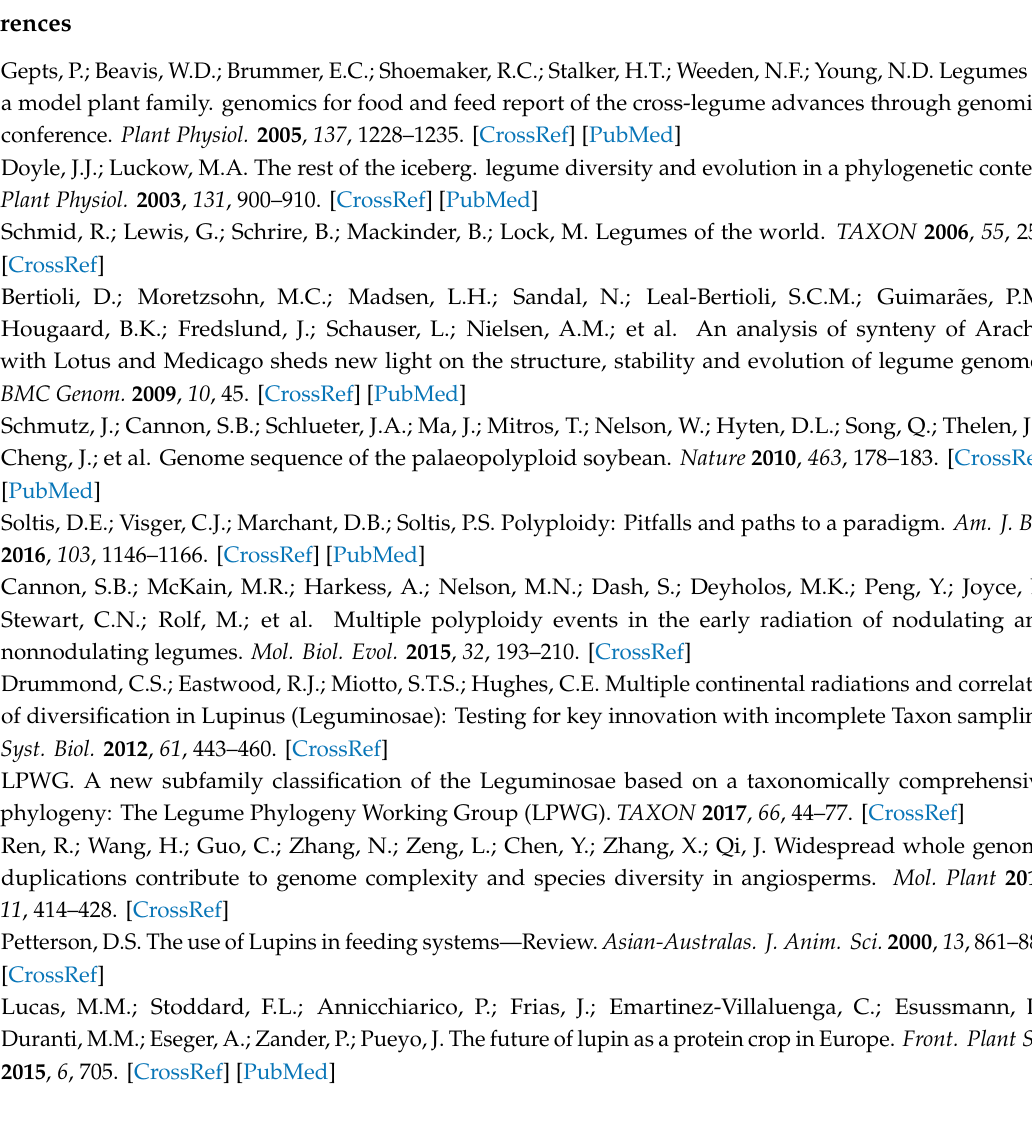
Figure S1: FISH mapping of oligonucleotide probes in meiotic chromosomes of L. angustifolius , Table S1: Position of BAC clones in the pseudochromosome Lang06 of L. angustifolius cv. Tanjil mapped using BLAST in Geneious R9.1.8., Table S2: Alignment of BAC clone 076K16 to L. albus genome mapped using BLAST in White Lupin Genome Sequence Server 1.0.11. The detailed list of used oligonucleotide probes is available online at doi.org / 10.5281 /